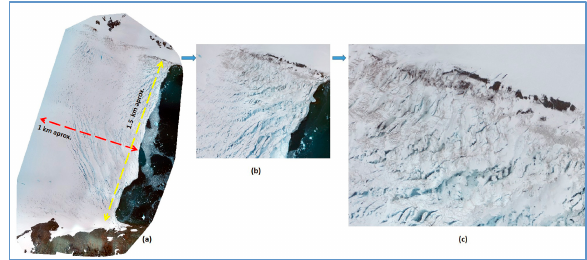
Figure 5. View of orthomosaic at different scales: (a) 1: 10,000 (b) 1: 2,000 and (c) 1: 1,000